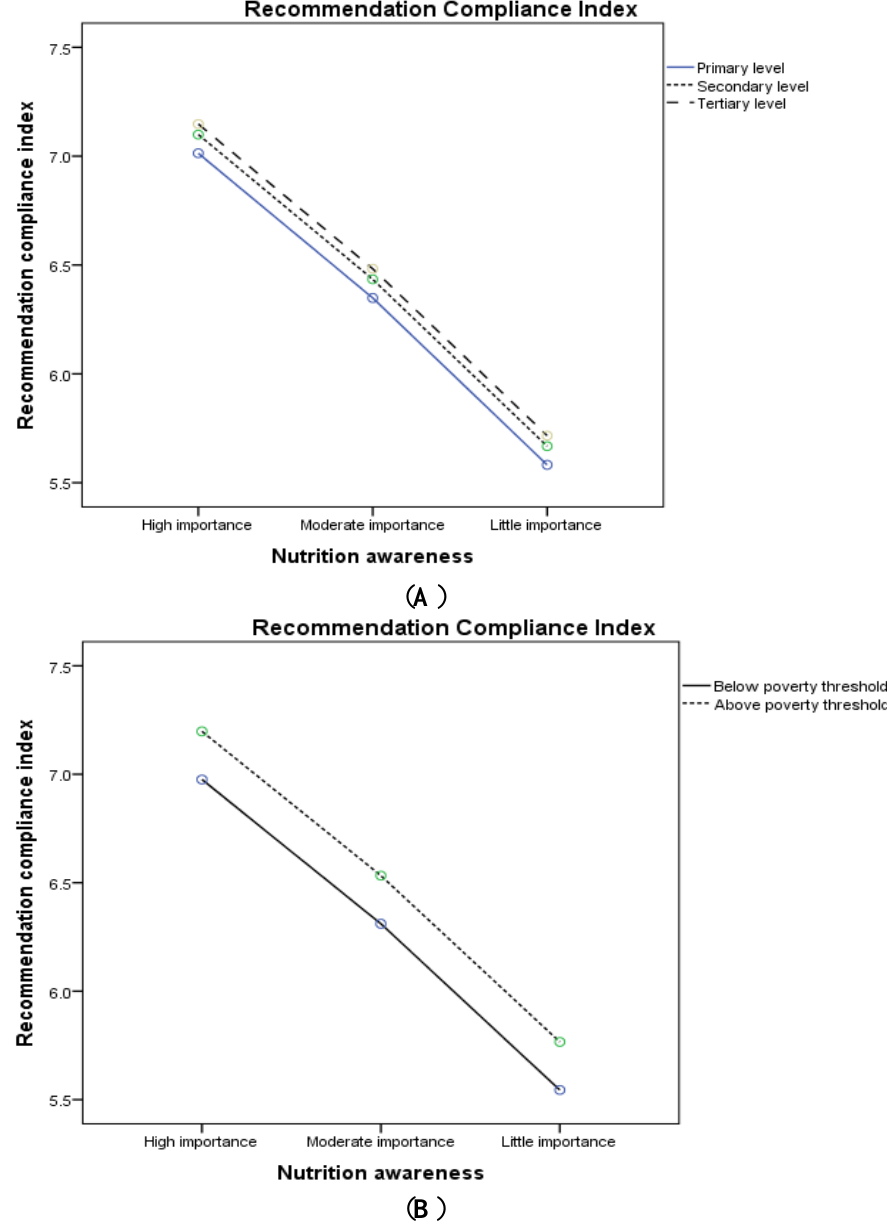
Figure 3. Covariate-adjusted mean * of recommendation compliance index across levels of nutritional awareness by ( A ) education level (* adjusted for age, sex, country of birth, BMI, income, and total energy intake); ( B ) household poverty threshold (* adjusted for age, sex, country of birth, BMI, education level, and total energy